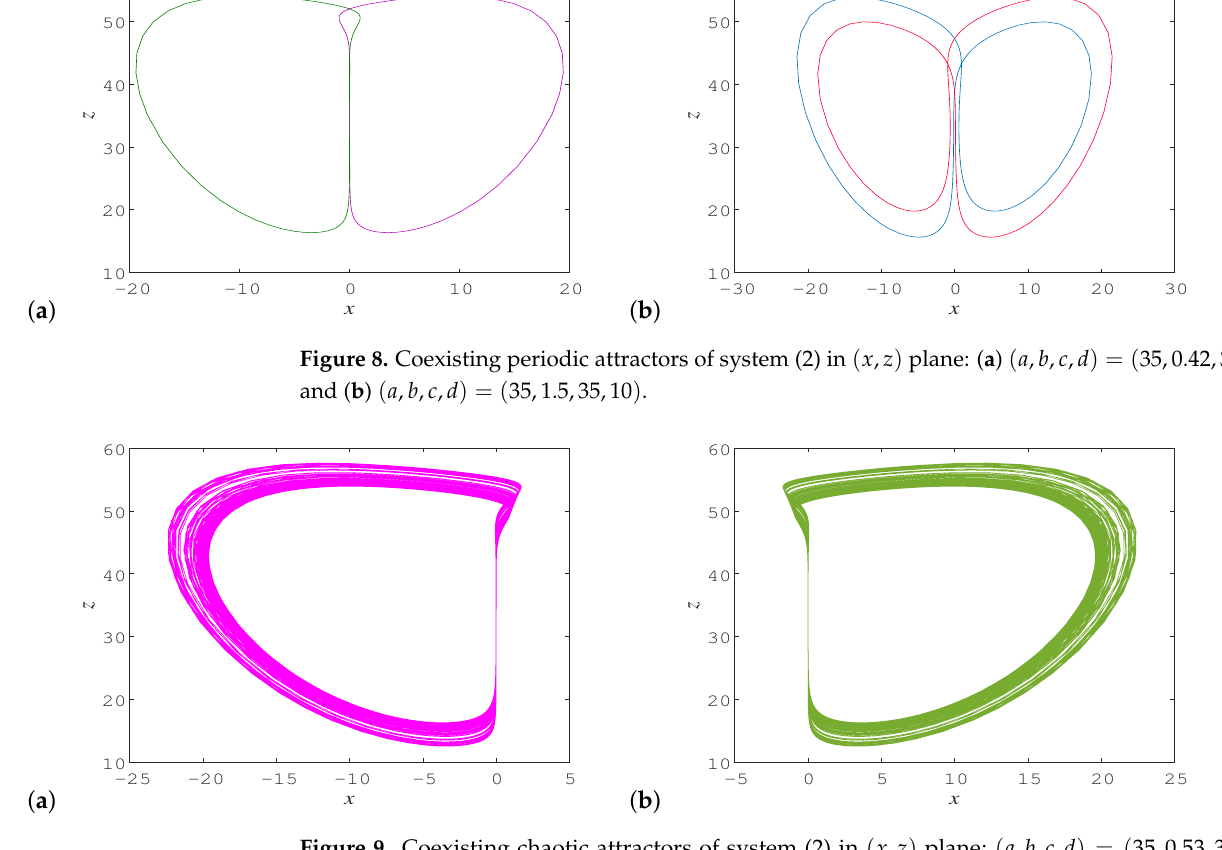
Figure 9. Coexisting chaotic attractors of system (2) in ( x , z ) plane; ( a , b , c , d ) = ( 35,0.53,35,10 ) : ( a ) chaotic attractor with initial values ( − 1, − 1,1 ) and ( b ) another chaotic attractor with initial values ( 1,1,1 )